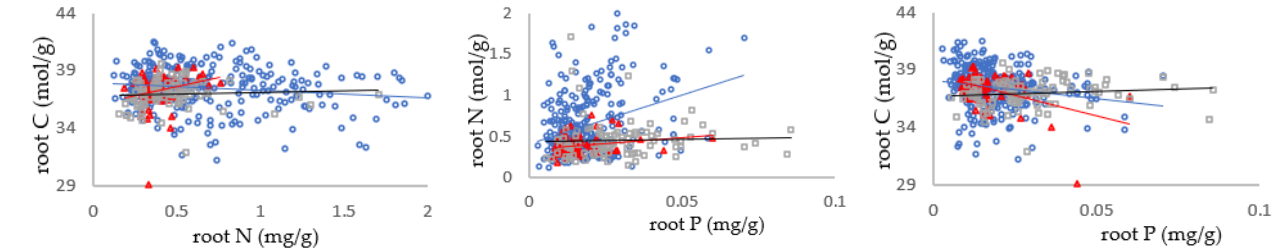
Figure 4. The relationship between the ratio of C, N, and P in roots for different mycorrhizal types. The blue cycles and blue lines mean AM, the red triangles and red lines mean AM + ECM, and the gray squares and black lines mean ECM.